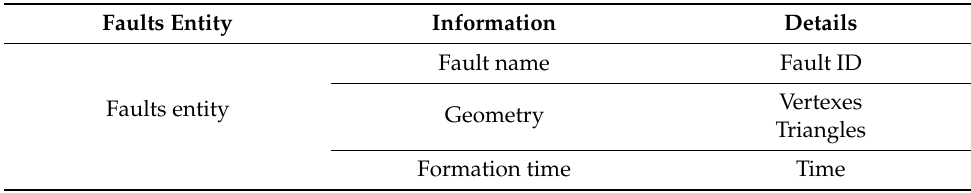
Table 1. Record Template of Fault Surface Entity Model.